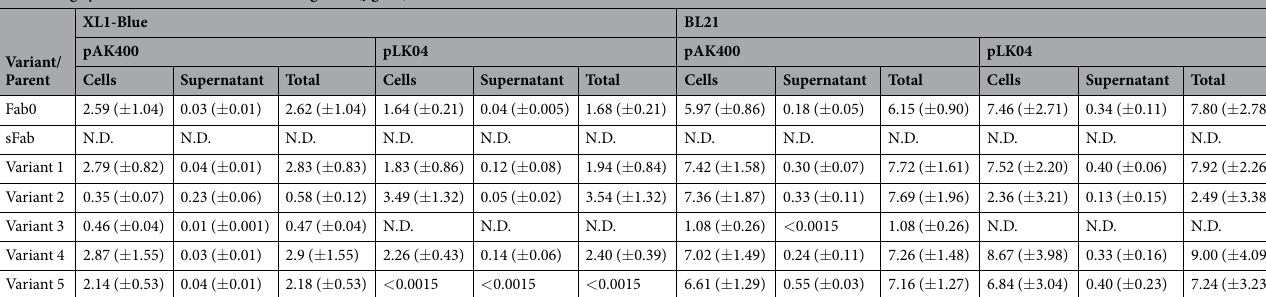
Table 2. The average yields of immunoreactive Fab fragment. The average yields of immunoreactive Fab fragment of the parent genes and the variants from three independent cultures are shown in the table. The standard deviations of the yields are shown in parentheses. N.D. = not